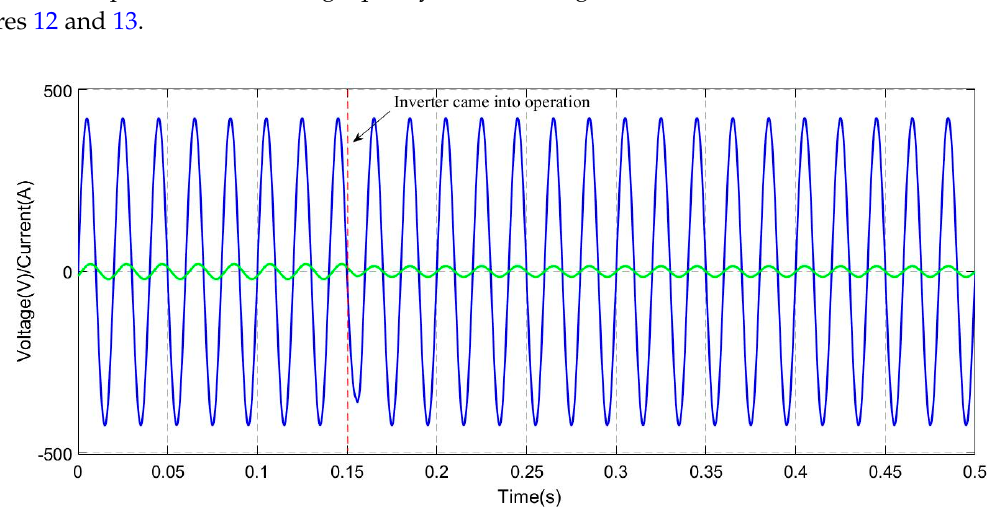
Figure 12. Waveforms of phase A voltage and current at load.